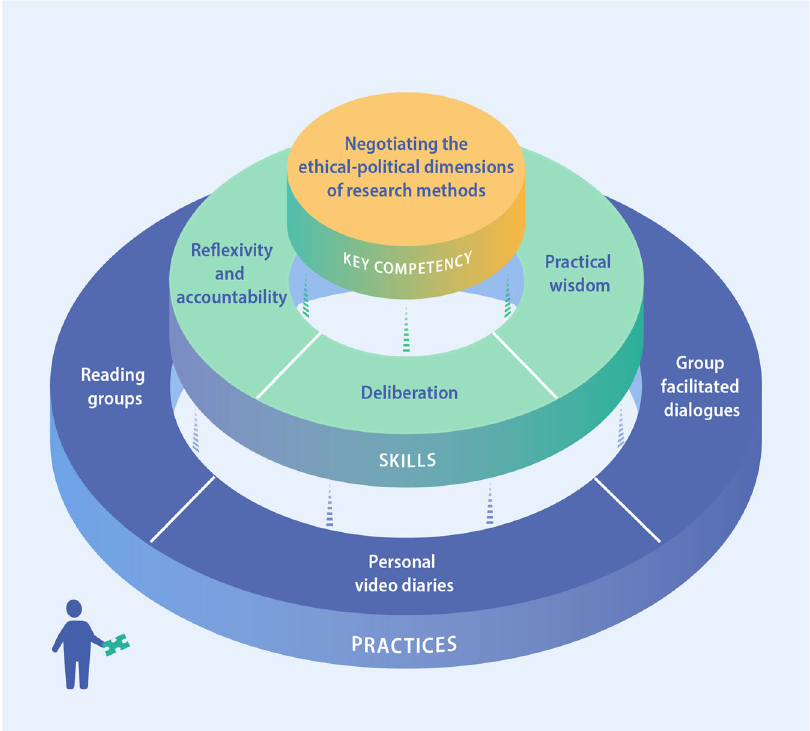
Fig. 2 Developing the competency to negotiate the ethical-political dimensions of research methods. In the New Normal project we engaged in practices including reading groups in philosophy, ethics and social studies of science, personal video diaries, and group facilitated dialogues. These practices helped us to develop skills in re fl exivity and accountability, deliberation and practical wisdom, which in turn enhanced our competency to negotiate the ethical political dimensions of our research methods. Illustration by Elsa